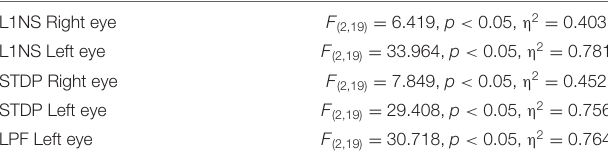
TABLE 2 | Repeated measure one-way ANOVA for each metric with effect size. L1NS Right eye